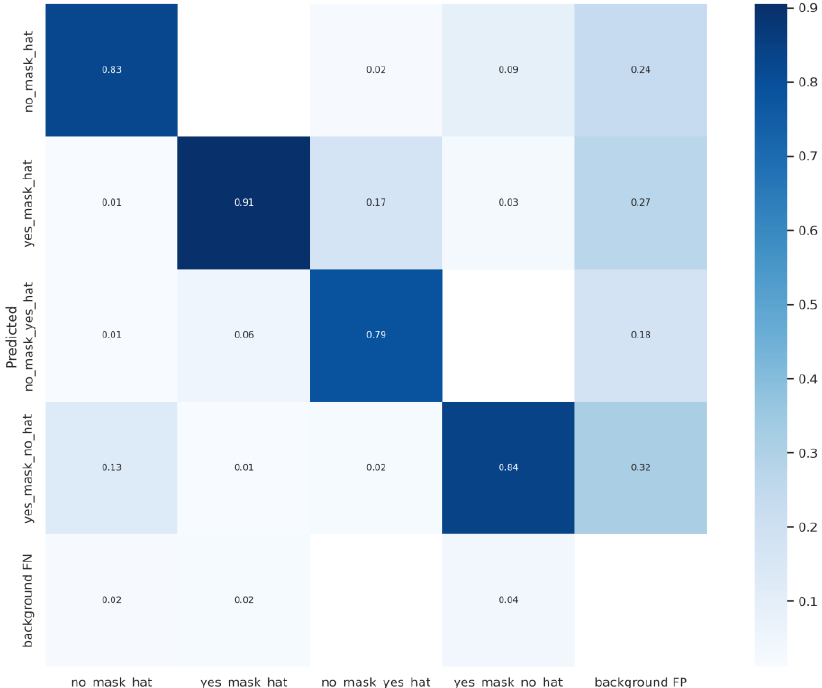
Figure 7. The confusion matrix obtained from various kitchen dress states.